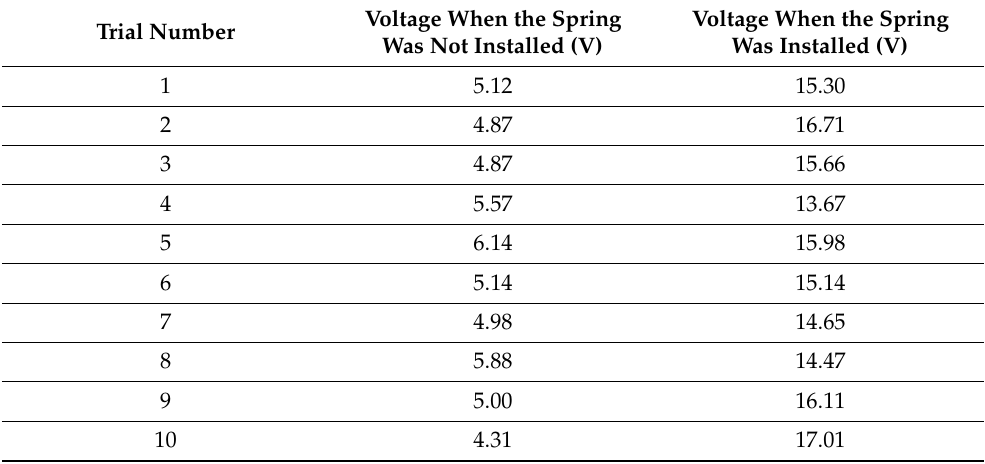
Table 4. Voltage measurements with and without the spring installed on the power-generating floor. Voltage When the Spring Trial Number